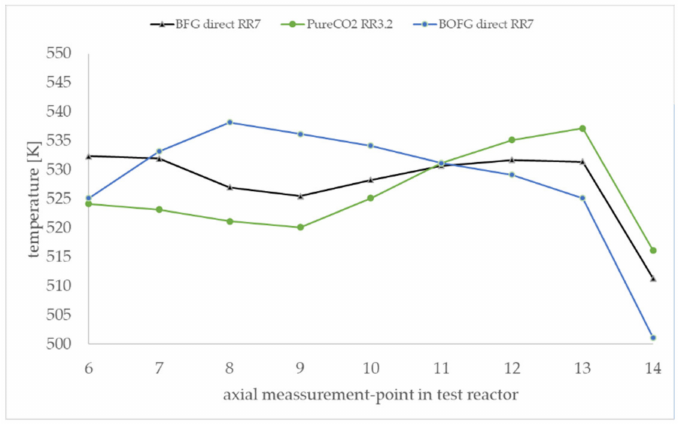
Figure 10. Axial temperature profile measured at 9 equidistant measurement points inside the catalytic fixed bed of 60 cm total